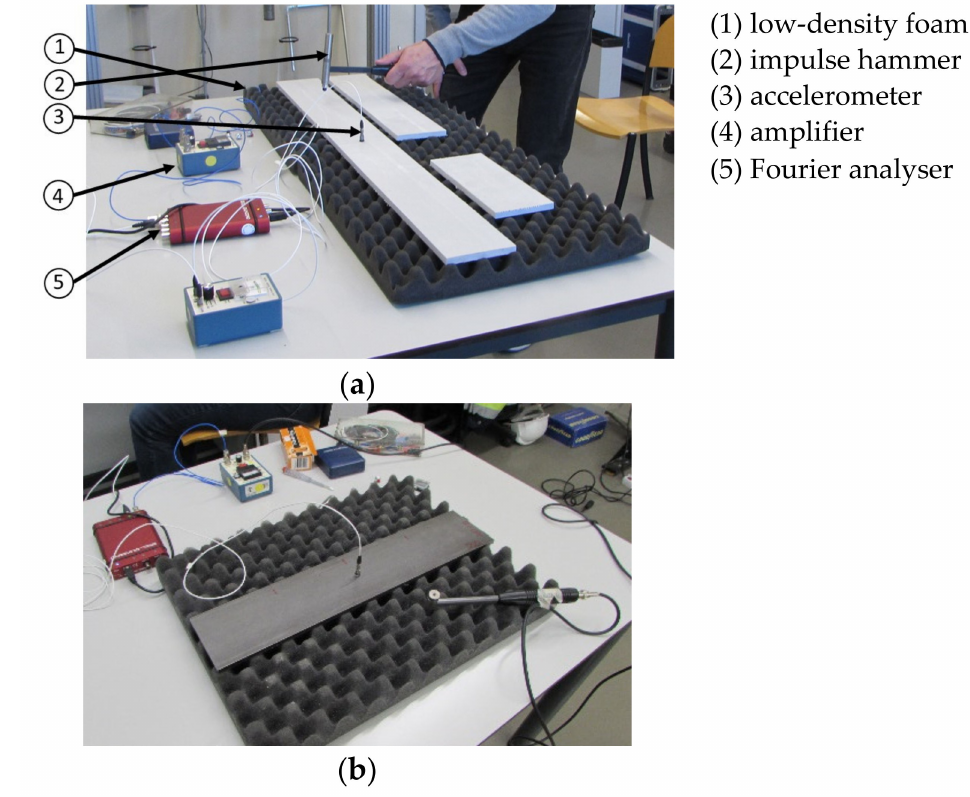
Figure 6. Experimental setup: ( a ) GFRP and ( b ) steel specimens.